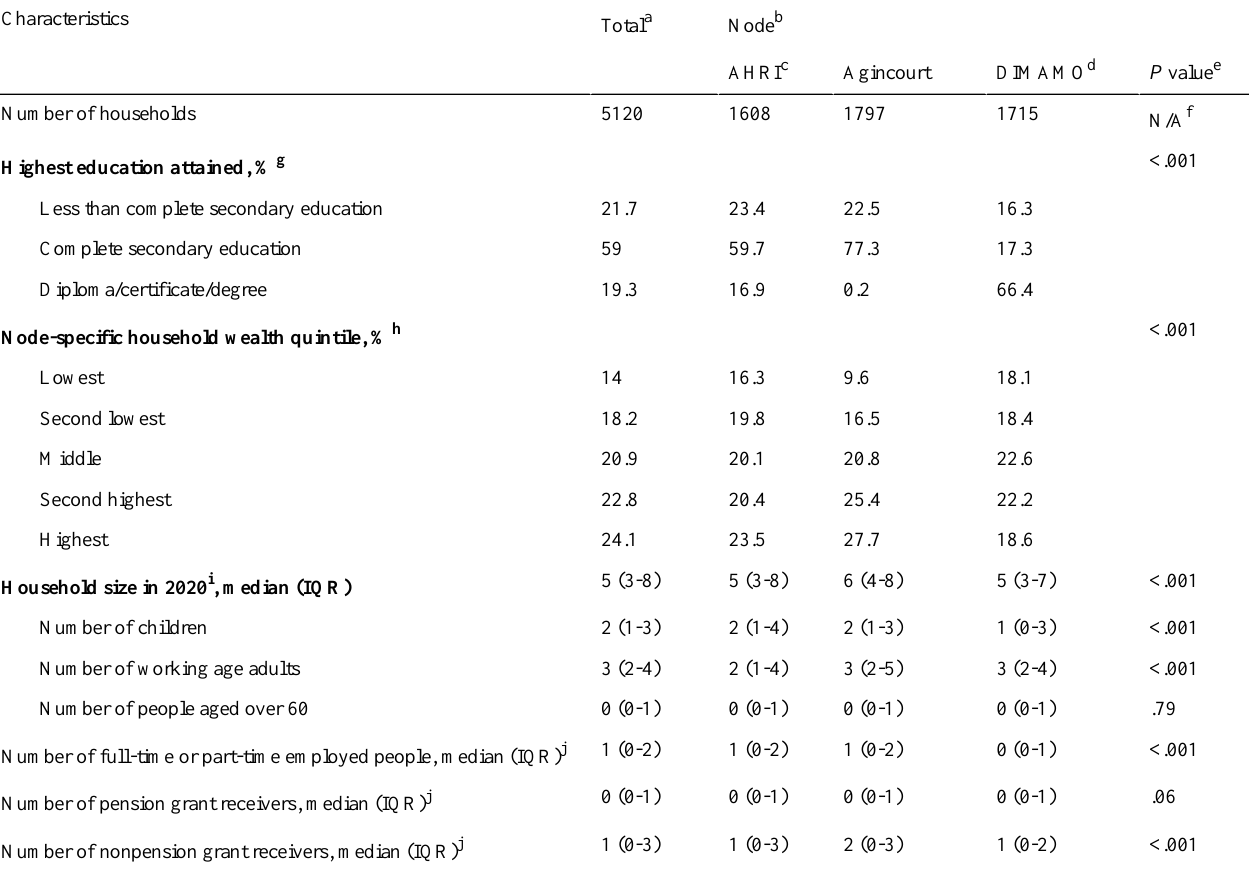
Table 1. Descriptive statistics for participating households at South African Population Research Infrastructure Network nodes from April to